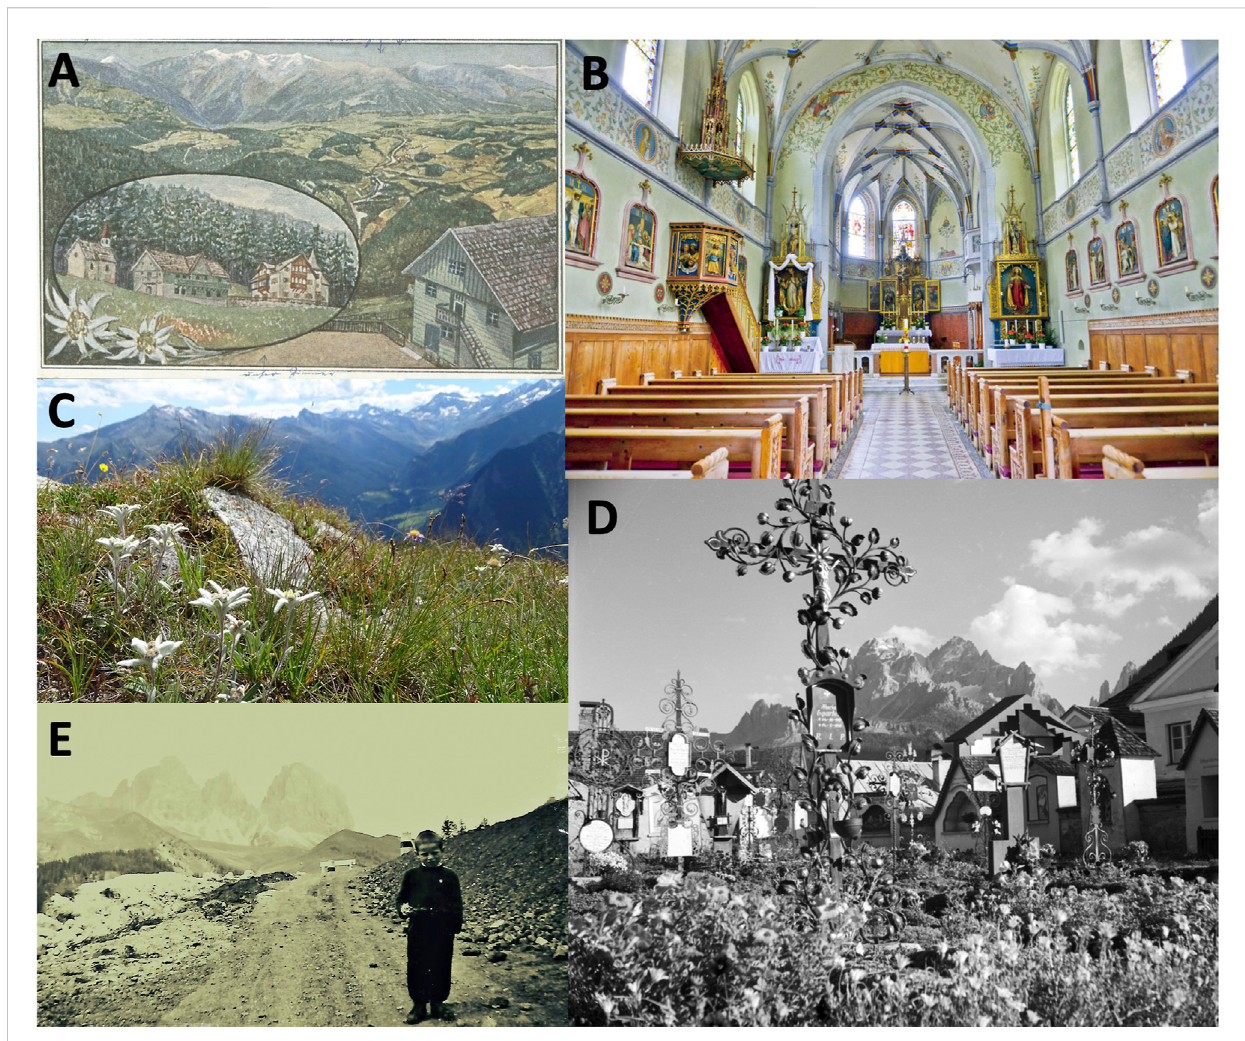
Some impressions on traditional medicinal plants in South Tyrolean landscapes. (A) Postcard Bad Ramwald with Leontopodium nivale subsp. alpinum Cass. near St. Lorenzen in the Pustertal, South Tyrol (app. 1314m), 1910, Collection Monika Weissteiner, Municipal Archives Brunico. (B) Inside view of the parish church/Chiesa parrocchiale, Graun-Pedross, South Tyrol (app. 1520m). The neo-Gothic church in Pedross was built from 1908 to 1912. The patron saint of the church is St. Martin. On the ceiling of the whole church are depicted various herbs, fl owers and medicinal plants. Photographer: Walter Rampl (C) Leontopodium nivale in the Passeier Valley (app. 2100m). Photographer: Uwe Häntsch (Flickr). (D) The cemetery inSexten/Sesto,Pustertal,SouthTyrol,(app.1310m).Oldmetalgravecrosseshaveoftenornamentalmotifssuchasleaves, fl owersandfruits.The fl owers of Calendula of fi cinalis decoratetraditionally thegraves andsetsacounterpointto deathwithitslivelygrowth.This usehasalso givenitthename “ fl ower ofthedead ” .1965,CollectionFotoBaptist,TyroleanArchiveforPhotographicDocumentationandArt. (E) Childselling Leontopodiumnivale totouristsin South Tyrol around 1900. Historical photo, photographer unknown. All sources are CC BY